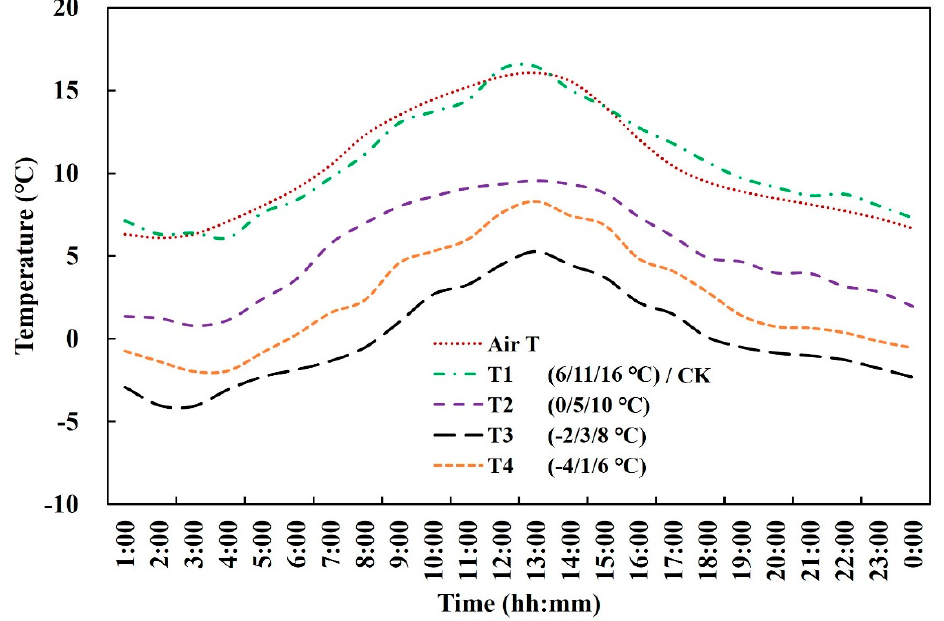
Figure 2. Daily temperature dynamics in one environment − controlled artificial climate chamber on 8 March 2018. Air T: ambient temperature. 8 March 2018. Air T: ambient